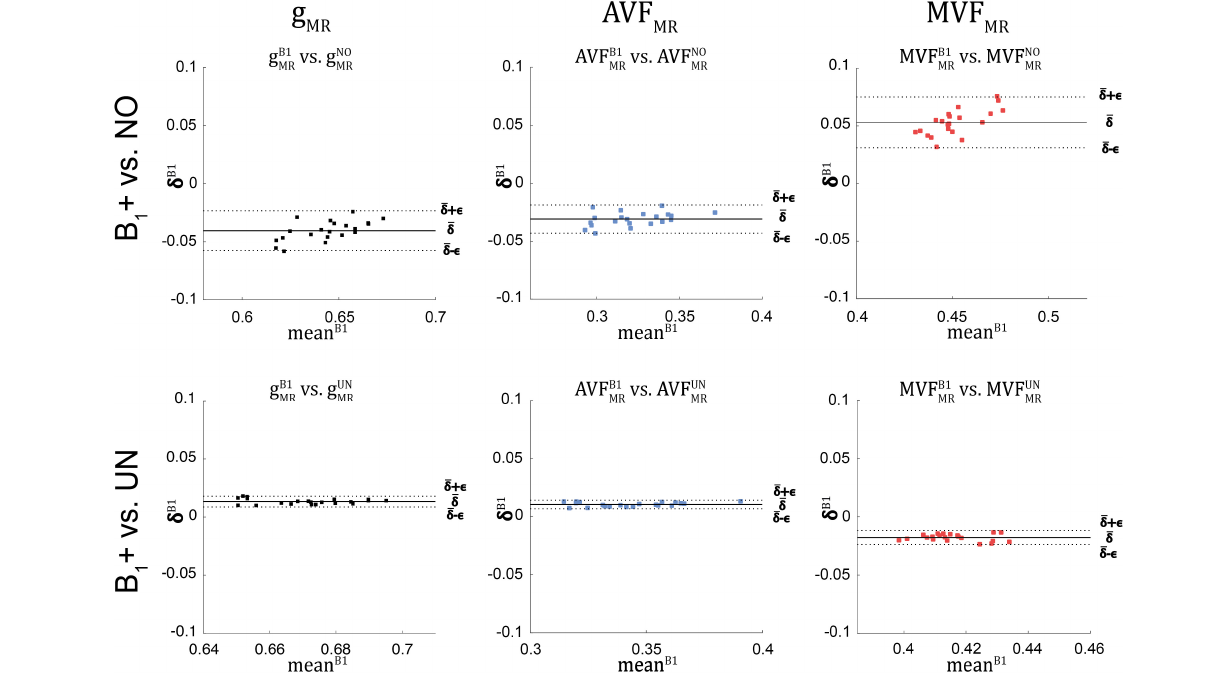
( g B1 MR ) ( g k MR ) i + i 2 , with k = (cid:8) UN , NO (cid:9) and i indexing the i th